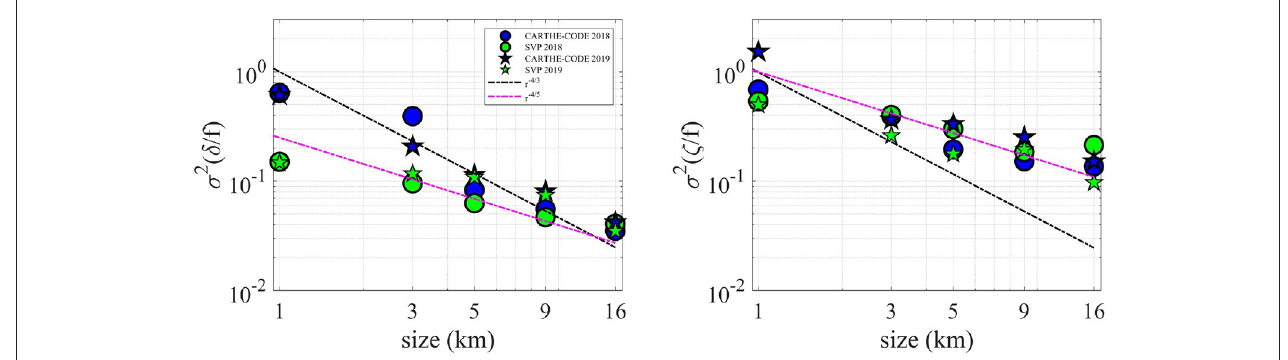
FIGURE 10 | Scale dependence of the variance of divergence (left) and vorticity (right) for both experiments (2018 circles, 2019 stars), and for the surface drifters (CARTHE and CODE) in blue and 15 m drifters (SVP) in green. For comparison, the scaling laws for velocity derivatives are also shown: black line for magenta line for 4/5 slope. −